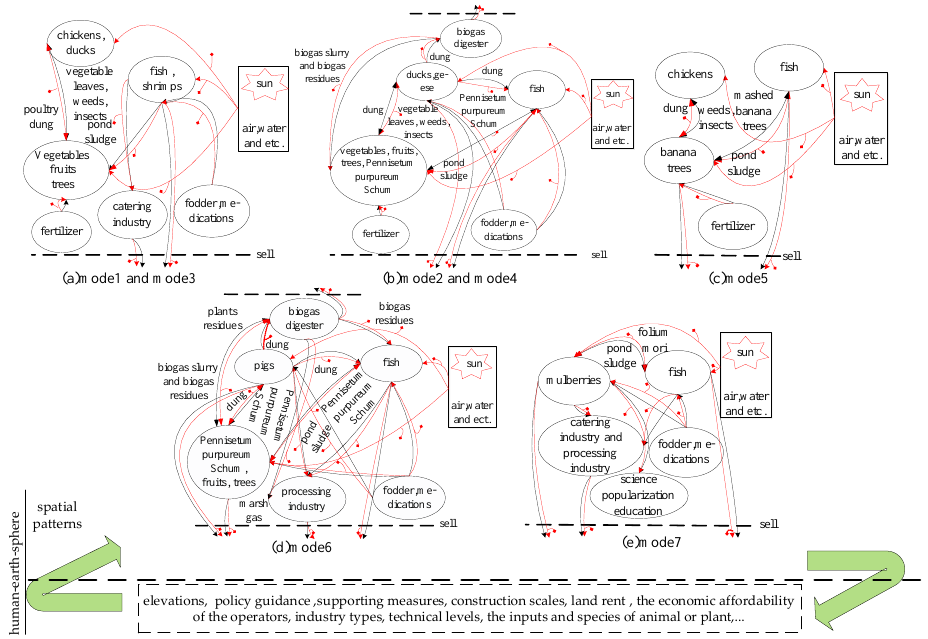
Figure 5. Relationships between material recycling and energy flow of different land-use modes of the dike–pond systems. Note: ( a – e ) represent the subfigures of Figure 5, and the black solid lines with the arrow line represent the relationships of material transformation between the elements in the systems, and the red solid lines with the arrow and round head represent the relationships of energy flows.